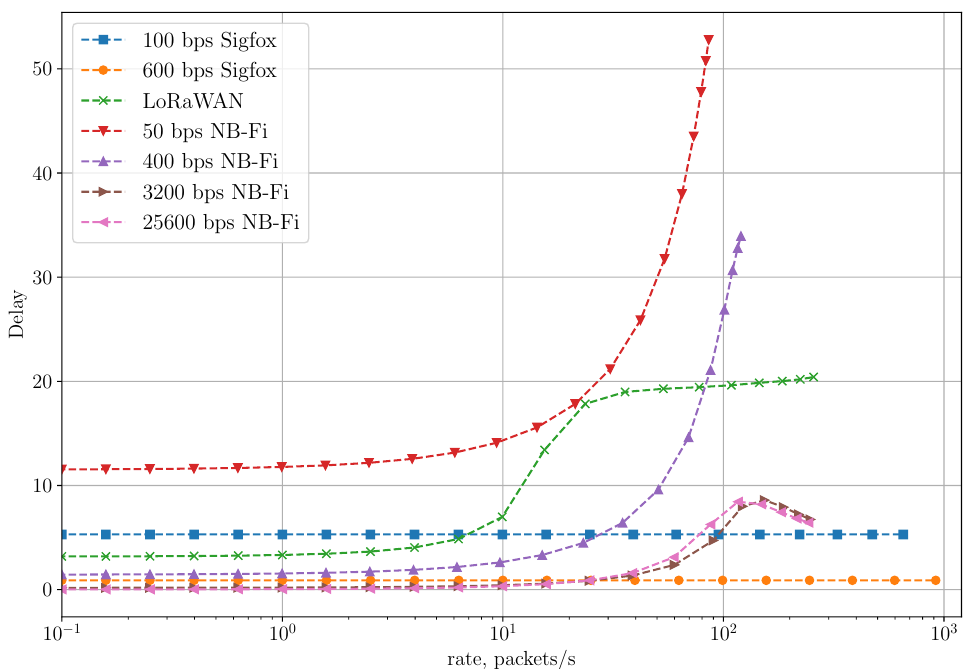
Figure 16. The average delay for the reliable transmission of short packets